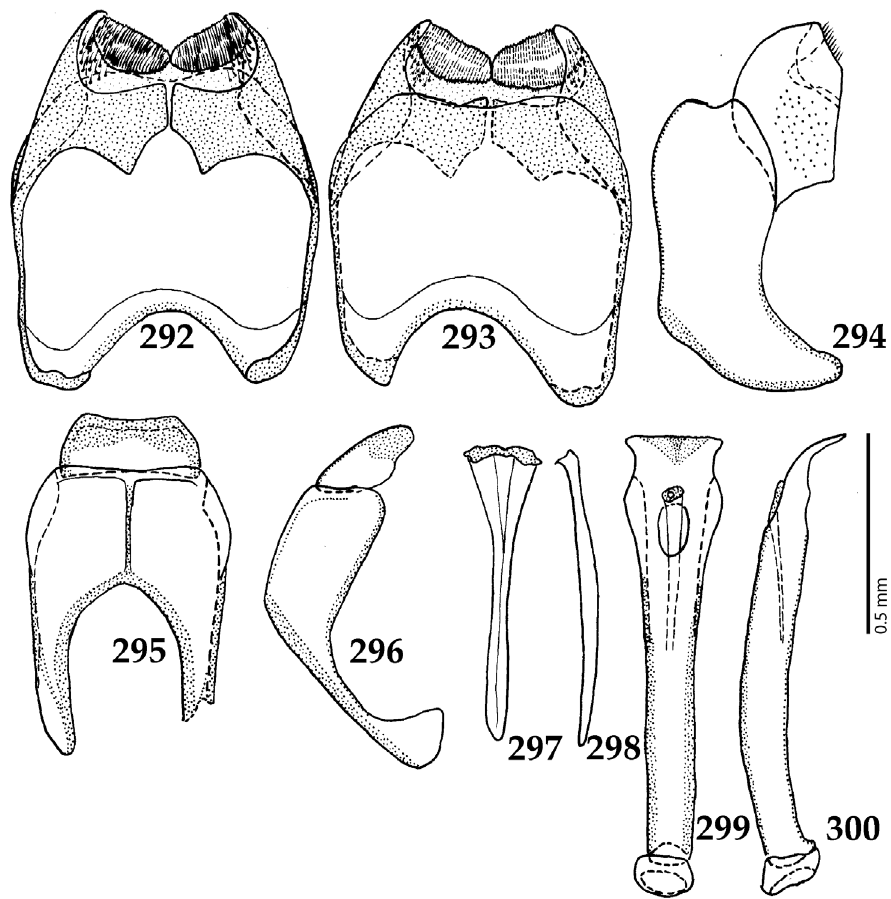
Figures 292–300. 292 Saprinodes falcifer Lewis, 1891 male terminalia: 8 th sternite + 8 th tergite, ven- tral view 293 ditto, dorsal view 294 ditto, lateral view 295 male terminalia: 9 th + 10 th tergites, dorsal view 296 ditto, lateral view 297 male terminalia: spiculum gastrale, ventral view 298 ditto, lateral view 299 male terminalia: aedeagus, dorsal view 300 ditto, lateral